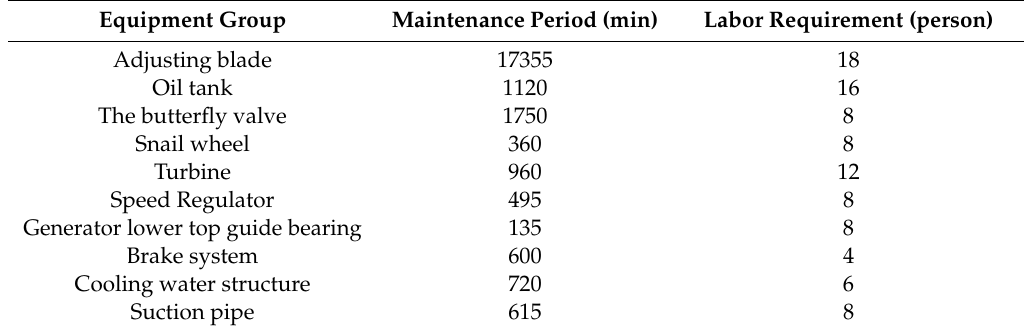
Table 4. Data on mechanical